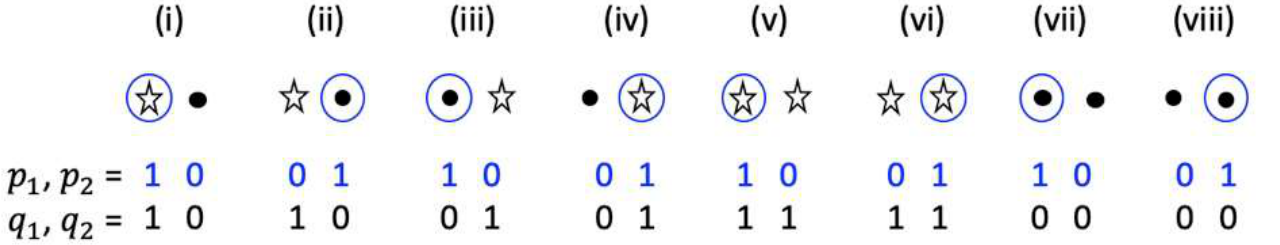
Figure 2. Seven different combinations of two distinct types of inputs representing percepts and the corresponding initial values of ( p 1 , p 2 ) and ( q 1 , q 2 ) processes. Each combination consists of two possible positions and the presence/absence of a light stimulus at these positions. The presence of a light stimulus at a position is indicated by the star sign and the absence of light is indicated by the black dot. A specific position is assumed to be selected by attention, which is indicated by the blue circle. For example, for case (i), the focus is on the bright spot, while for case (ii), the focus is on the dark spot.